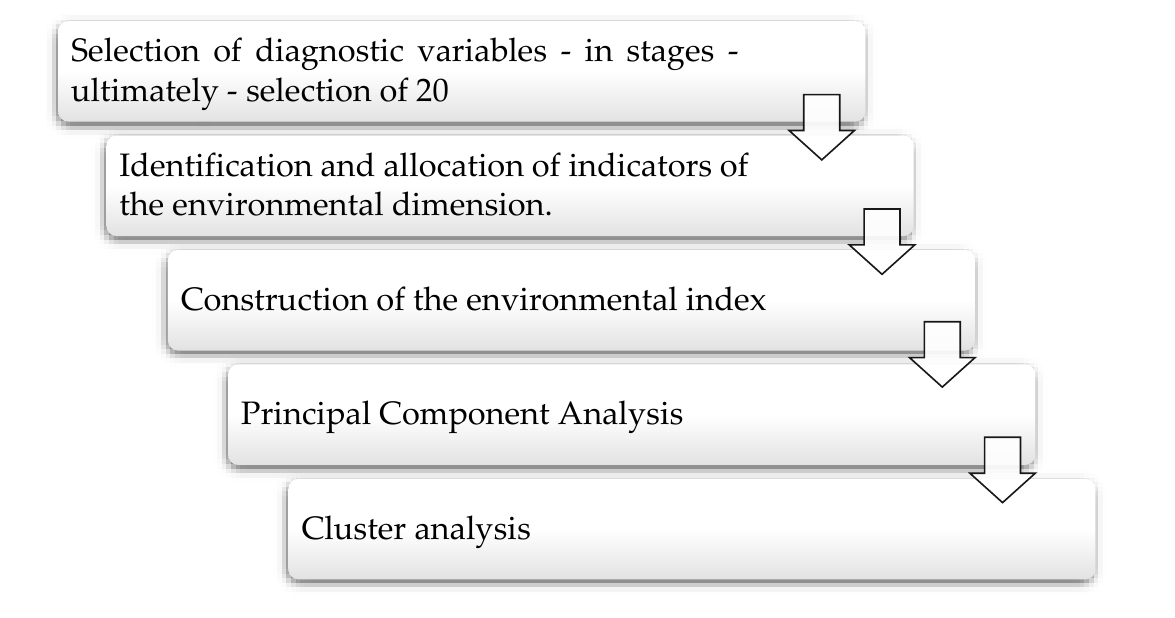
Figure 1. Graphic presentation of the research methodology .